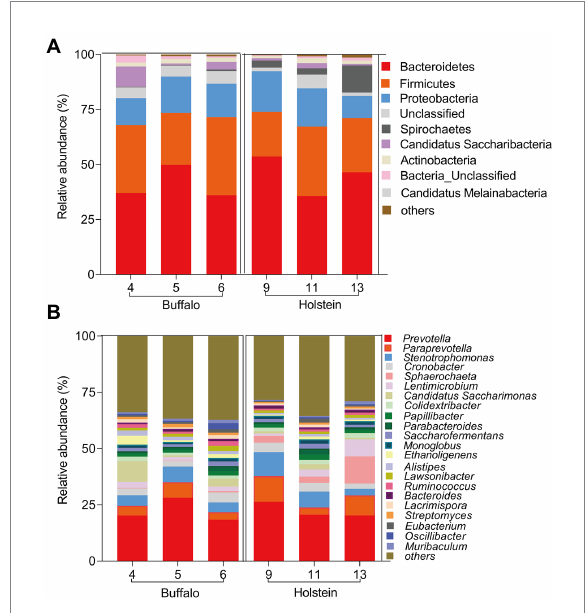
FIGURE 1 Bacterial community in buffalo or Holstein rumen microbiome at phylum (A) and genus level (B) . Numbers 4, 5, and 6 represent the ear tags of buffalo, while numbers 9, 11, and 13 represent the ear tags of